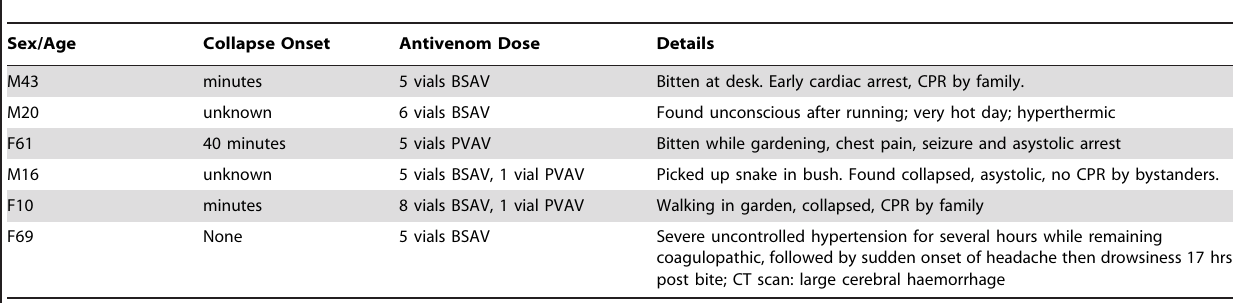
Table 3. Details of the six deaths from brown snake envenoming.